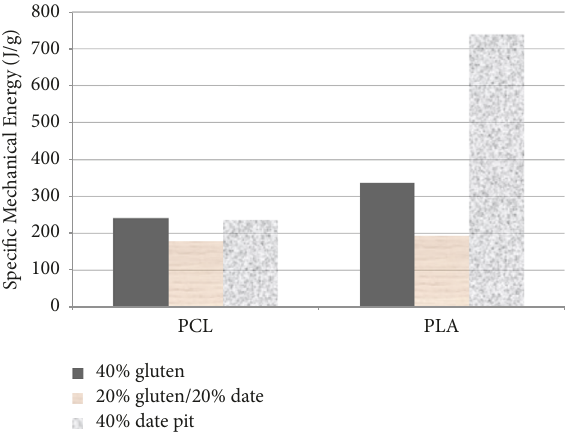
Figure 1: Specific mechanical energy during extrusion processing of PCL and PLA composite blends with date pits.